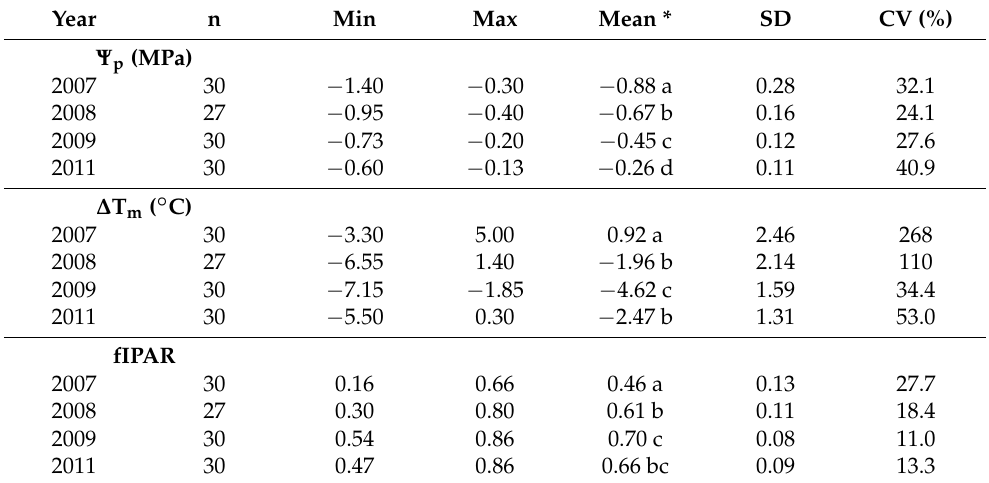
Table 3. Descriptive statistics for predawn water potential ( Ψ p ), canopy to air temperature difference ( ∆ T m ) and fractional intercepted PAR (fIPAR): number of vines (n), minimum (Min), maximum (Max) and Mean values, standard deviation (SD) and coefficient of variation